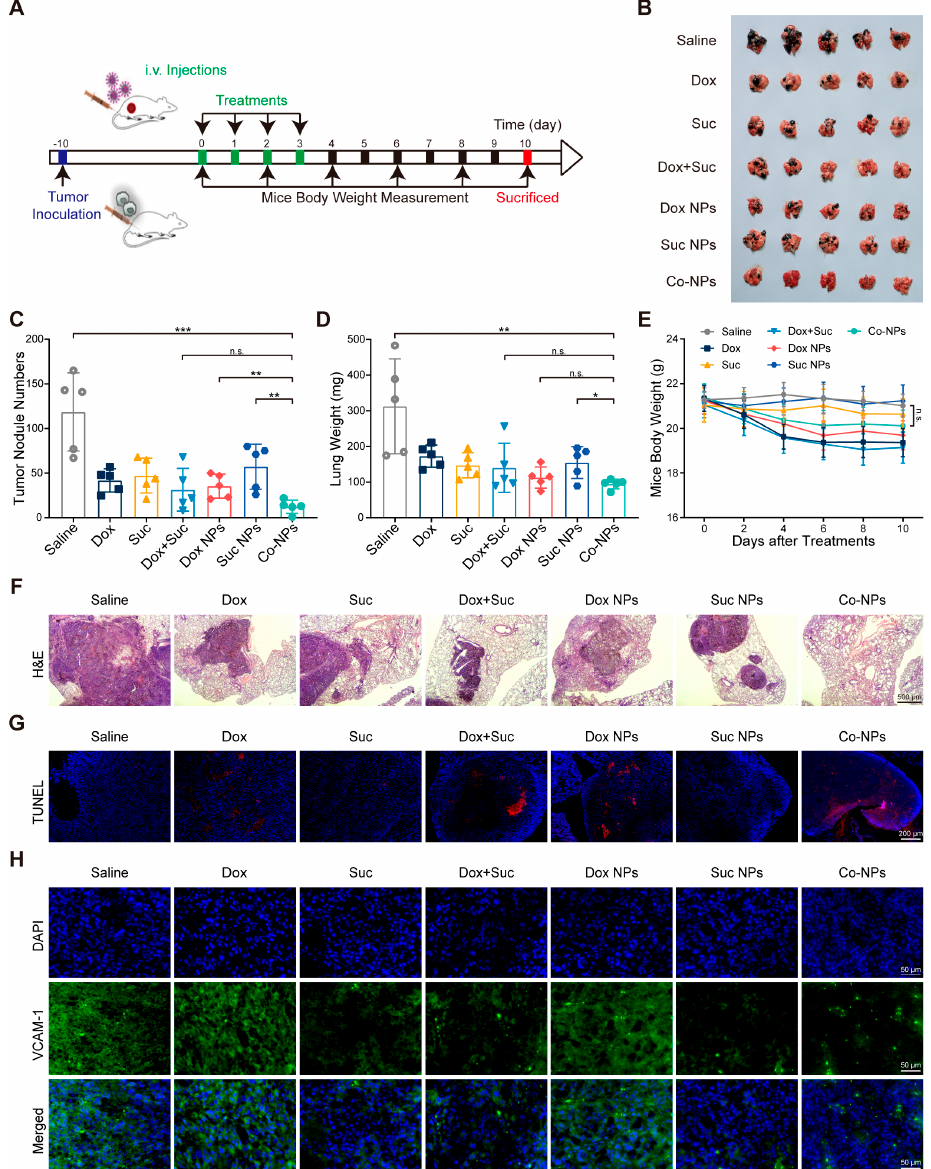
Figure 7. In vivo anti-lung metastasis efficacy. ( A ) Workflow for the treatment of B16F10 melanoma lung metastasis-bearing mice. On day 0 (defined as the 11th day after tumor inoculation), day 1, day 2, and day 3, mice were administrated with saline, Dox, Suc, Dox + Suc, Dox NPs, Suc NPs, and Co-NPs. Body weight of mice was monitored every 2 days from day 0 to day 10. ( B ) Photograph of lungs collected on day 11. ( C ) Tumor nodule numbers on the harvested lungs from individual groups after different treatments. ( D ) Lung weight of mice for individual groups after different treatments. ( E ) Changes of mice body weight during the treatments. ( F ) H&E staining of lung tissues after different treatments. Scale bar = 500 µ m. ( G ) TUNEL staining of lung tissues after different treatments. Scale bar = 200 µ m. ( H ) Immunofluorescence assay of VCAM-1 expression on lung tissues after different treatments. Scale bars = 50 µ m. (n.s., not significant, * p < 0.05, ** p < 0.01, *** p <